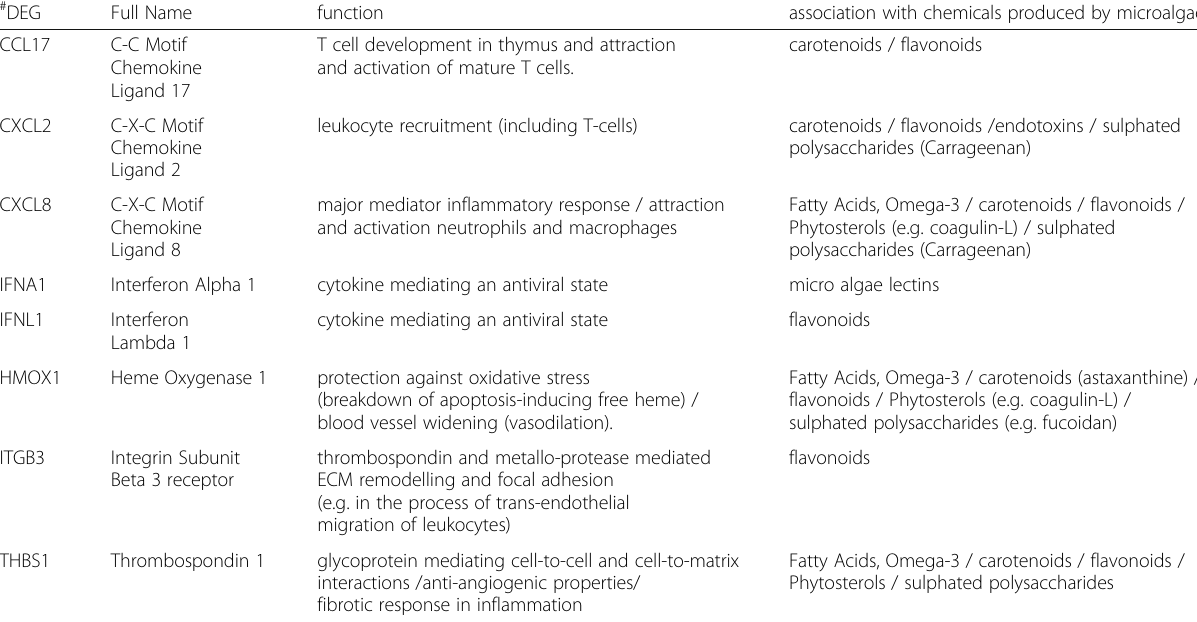
Table 6 Secreted immune EPs higher expressed in IPECJ2 cells upon exposure to micro algae extracts alone and mixtures of extracts and ETEC